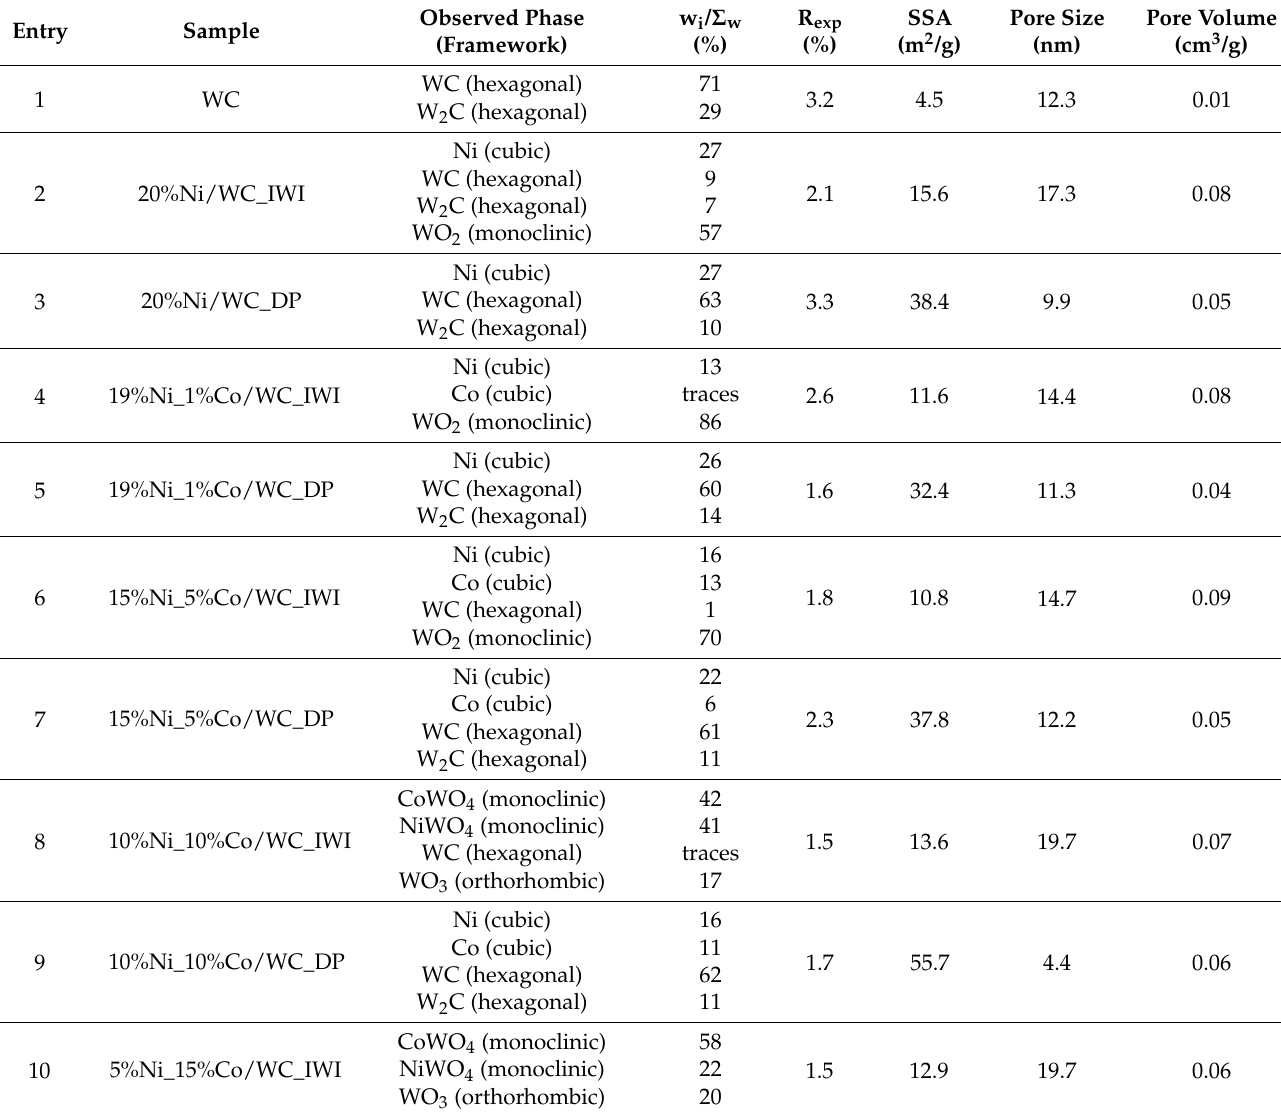
Table 1. Structural and textural characteristics of the studied catalysts and